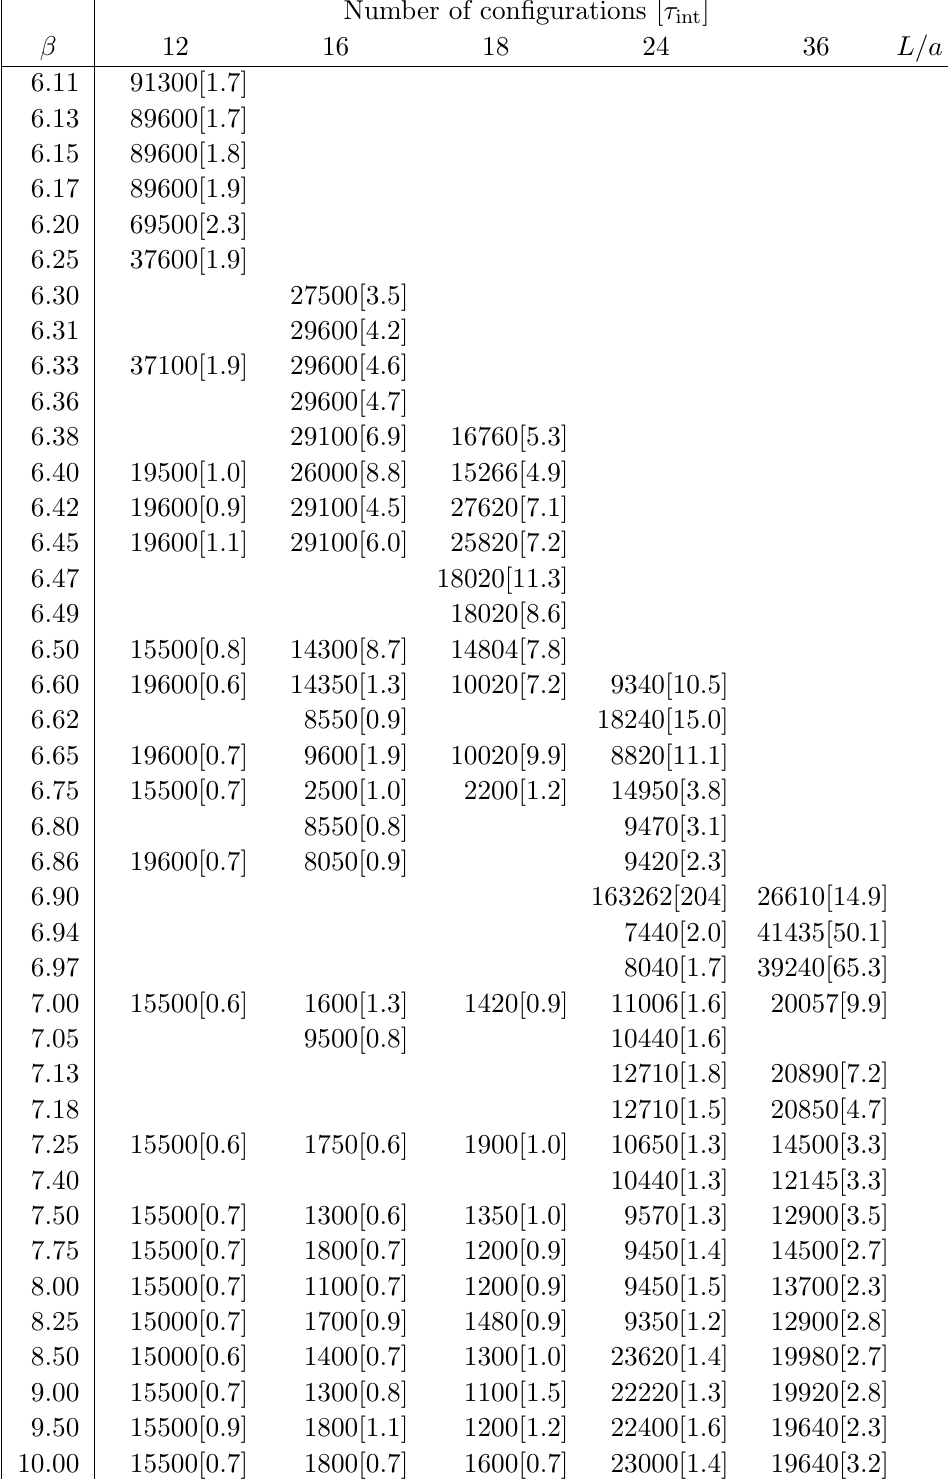
Table 10 . Number of con(cid:12)gurations after thermalization used to calculate g 2 integrated